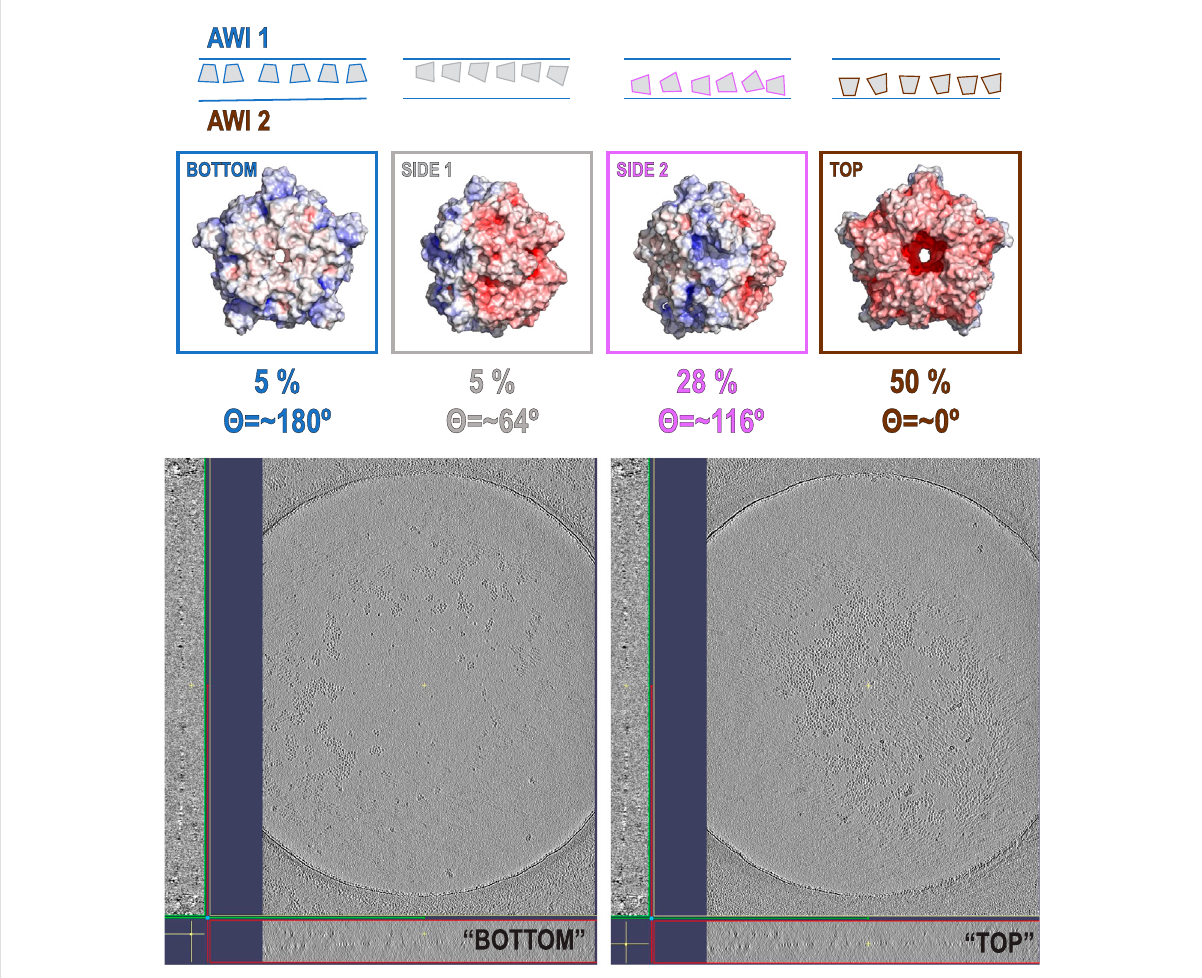
FIGURE 5 TomographicreconstructionofthesamplewithHis-tag presentinall copies.The upperpartofthe fi gure showsthedistributionoforientations for that sample, while the two panels at the bottom part of the fi gure represent the patterns on two different AWIs. One of the AWIs (left) shows very few particles in comparison with the second AWI (right). This is consistent with the results of our data analysis performed on a different subset of particles from the same type of sample. The particles in the sample are also forming “ groups ” that are not present in the sample with His-tags cleaved (Supplementary Figure S3A –